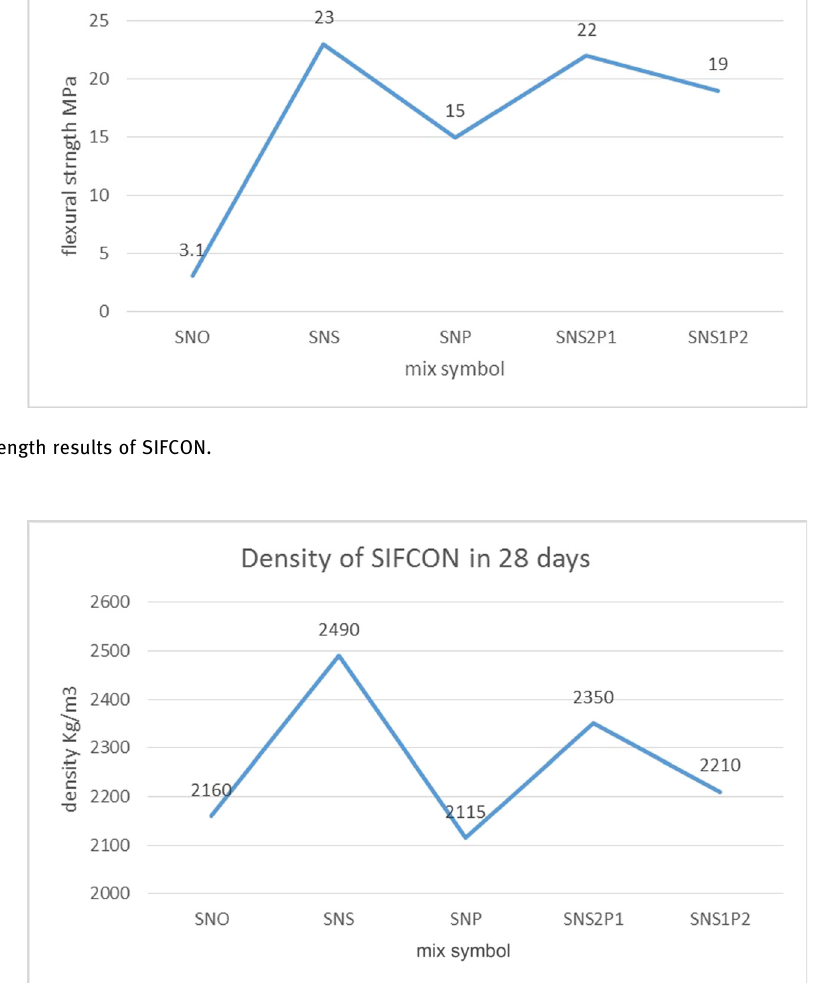
Figure 5: Oven dry density of